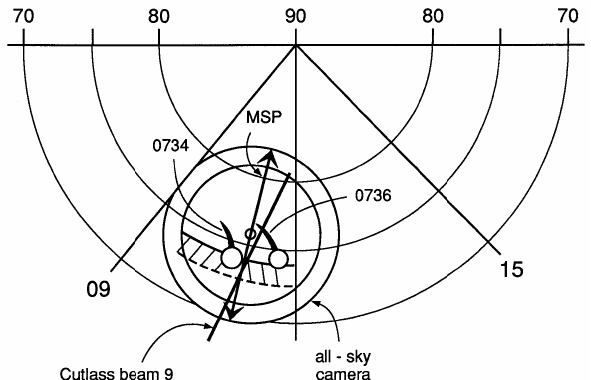
Fig. 4. Observation geometry with the poleward boundary of the cusp emission band (solid curved line) and the polar arc emanating from a bright spot (marked by small circle) in the vicinity of the cusp poleward boundary for 0734 and 0736 UT. Fields of view of the optical instruments (MSP and all-sky camera for both 630.0 and 557.7 nm emissions) at Ny Ålesund and beam 9 of the CUTLASS Finland HF radar have been marked.